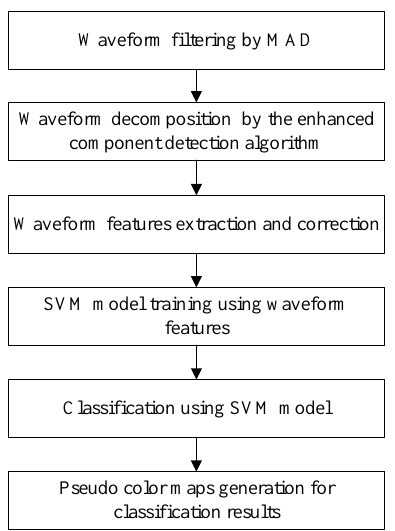
Figure 4. Flow chart for land cover classification of Miyun